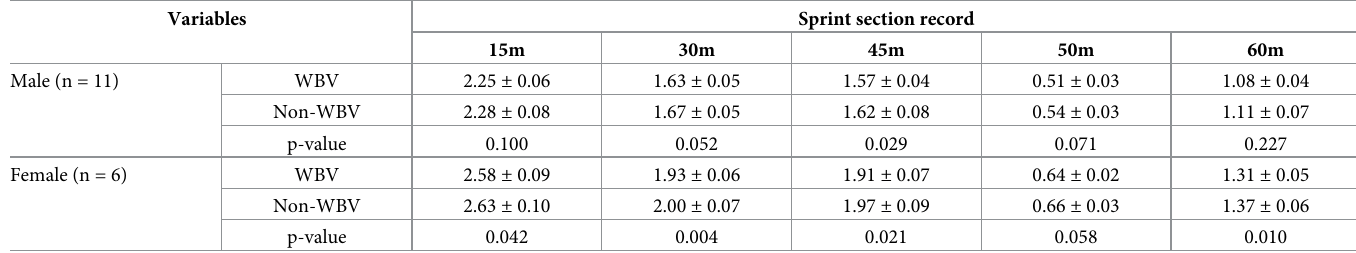
Table 2. The participants’ sprint section record.